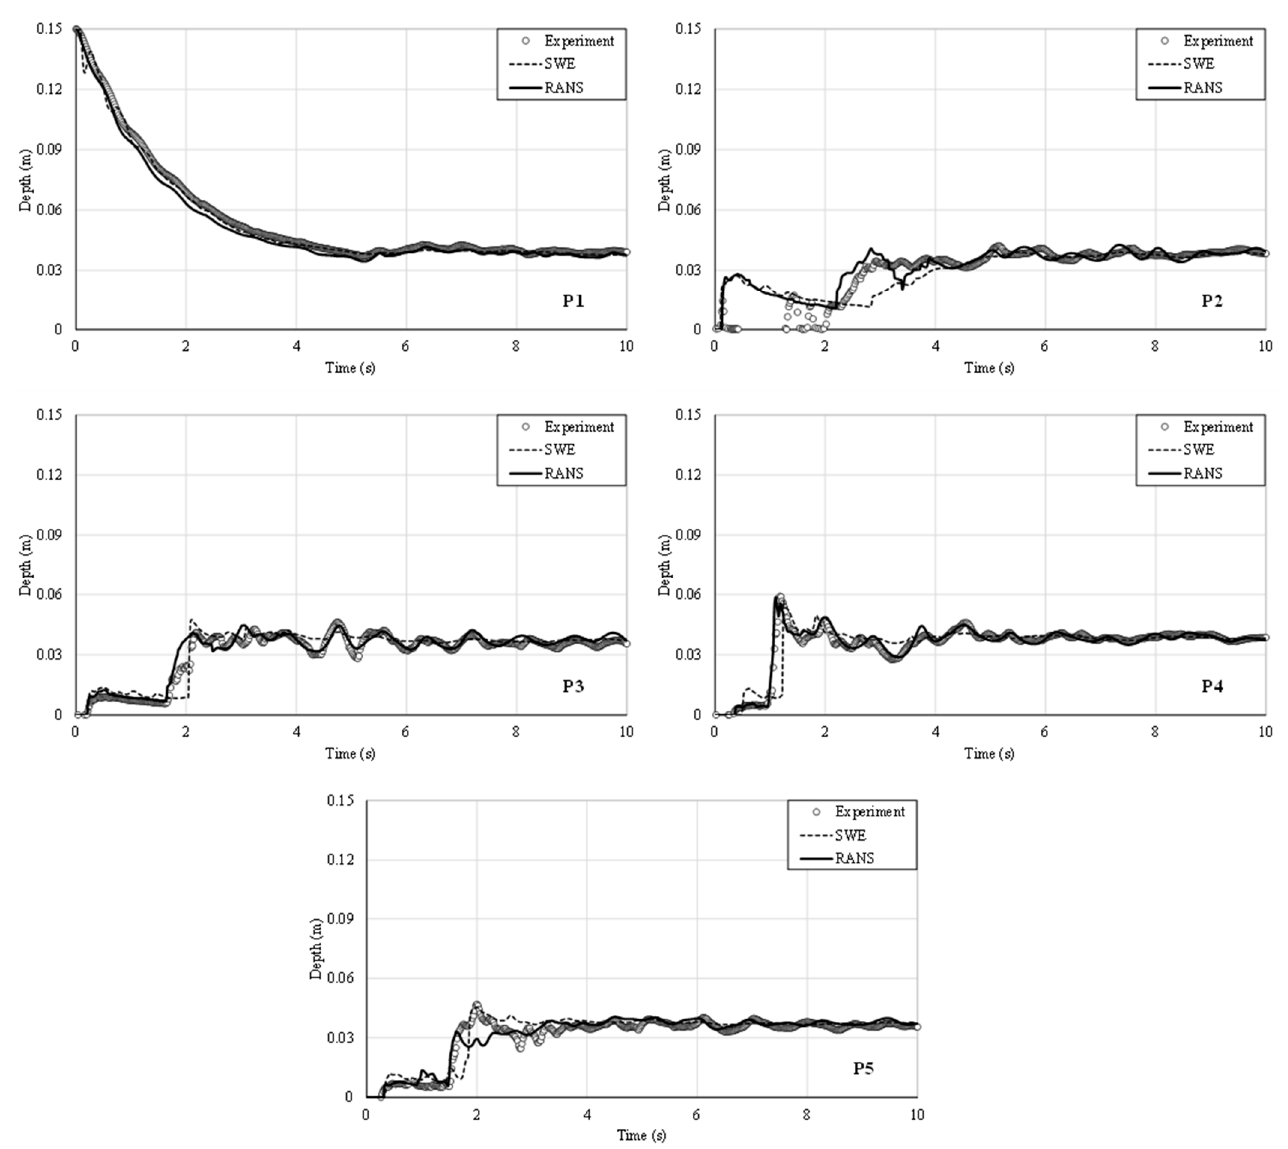
Figure 7. Comparison of experimental and numerical stage hydrographs (P1–P5 sensors) for test D1.